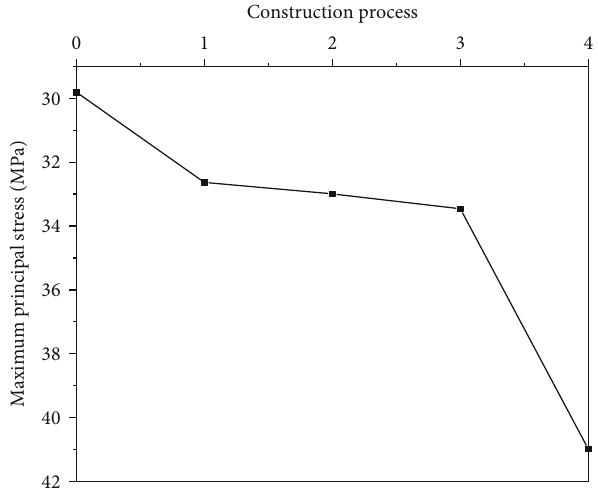
Figure 7: Maximum principal stress – construction